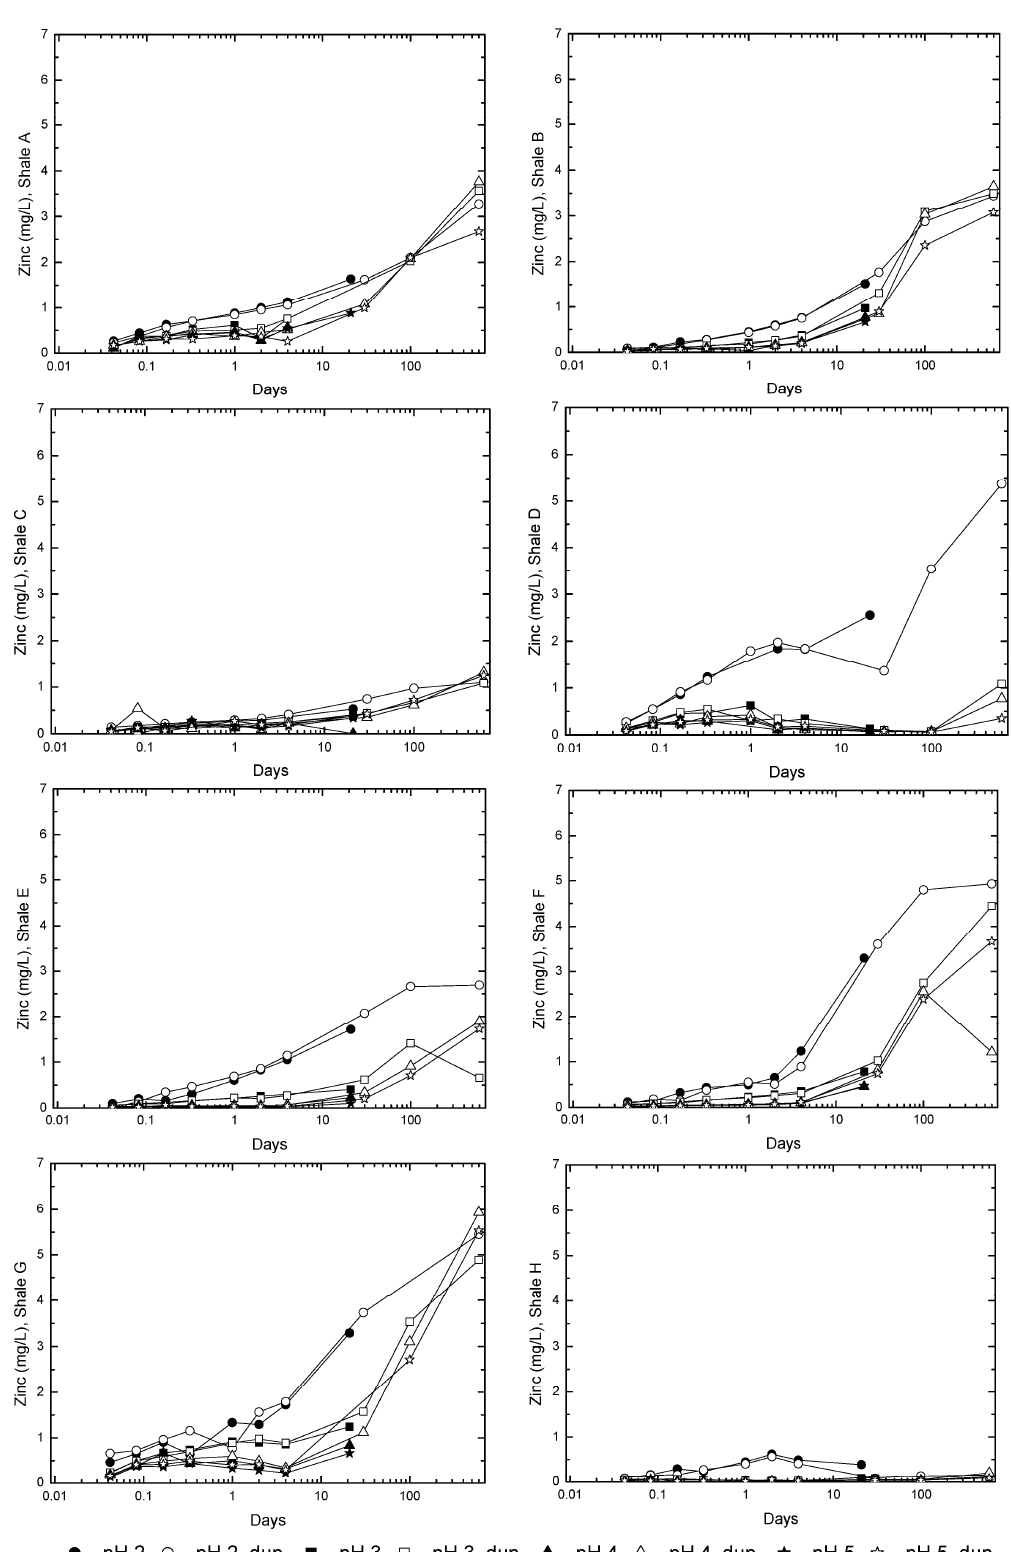
Figure 7. Solution Zinc concentration recorded over time for all reaction vessels for all samples. Points on lines mark sample intervals from experiment commencement and 1, 2, 3, and 8 h, and 1, 2, 4, 21, 30, 100 and 600 days (logarithmic scale). The legend indicates initial sample